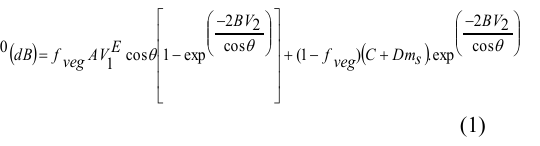
Figure 2.Flow chart of methodology for the present